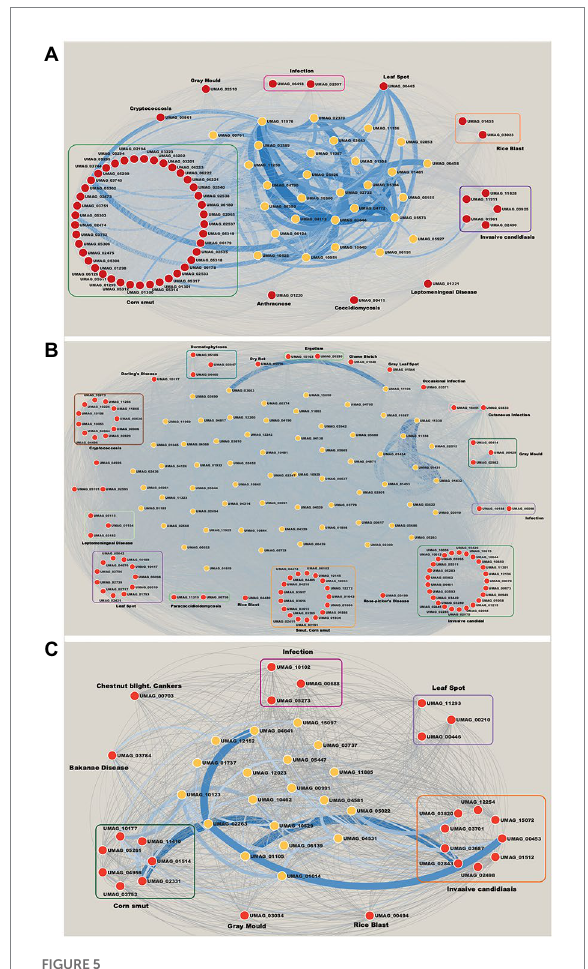
FIGURE 5 Networks of modules enrichment with virulence genes. (A) Brown module, (B) Magenta module, and (C) Yellow module. The virulence genes with their neighbor genes with the highest correlation were selected. The width of the edges is proportional to their correlation value. Red nodes are orthologs to virulence genes in Database of Virulence Factor in Fungal